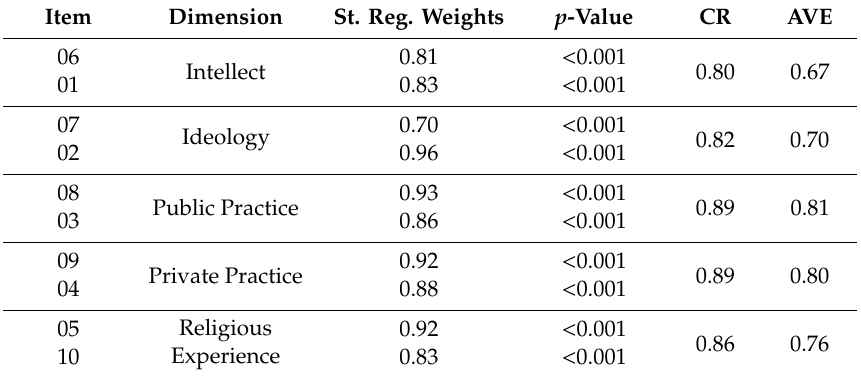
Table 7. Results for CRS-10 with five dimensions: Standardized regression weights, AVE, and CR.